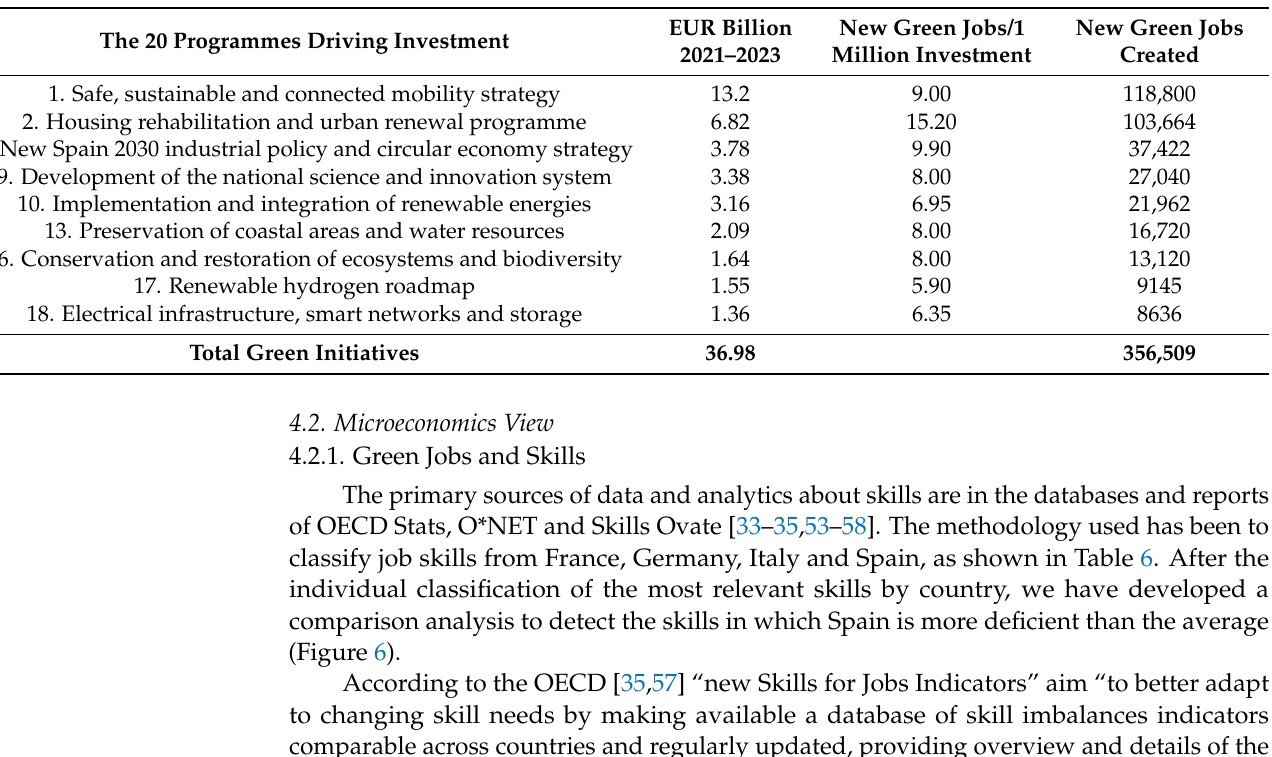
Table 7. Soft skills to improve in Spain. Source: own elaboration based on data from OECD data [57].